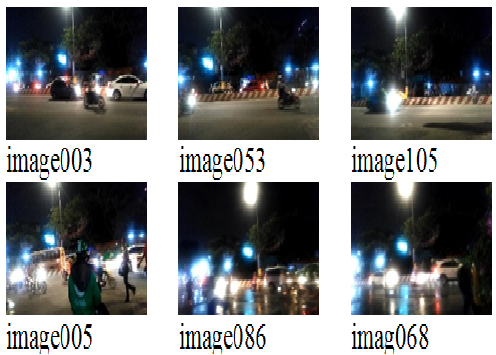
Fig. 6: Some tra(cid:30)c images extracted from a short video on Nguyen Huu Tho Street at